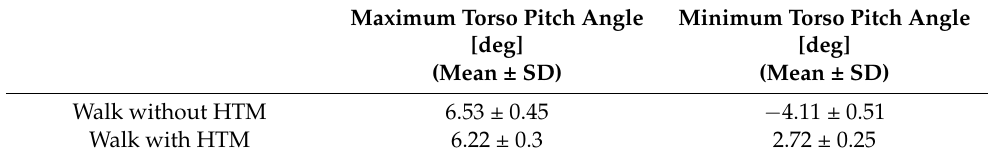
Table 7. The torso pitch